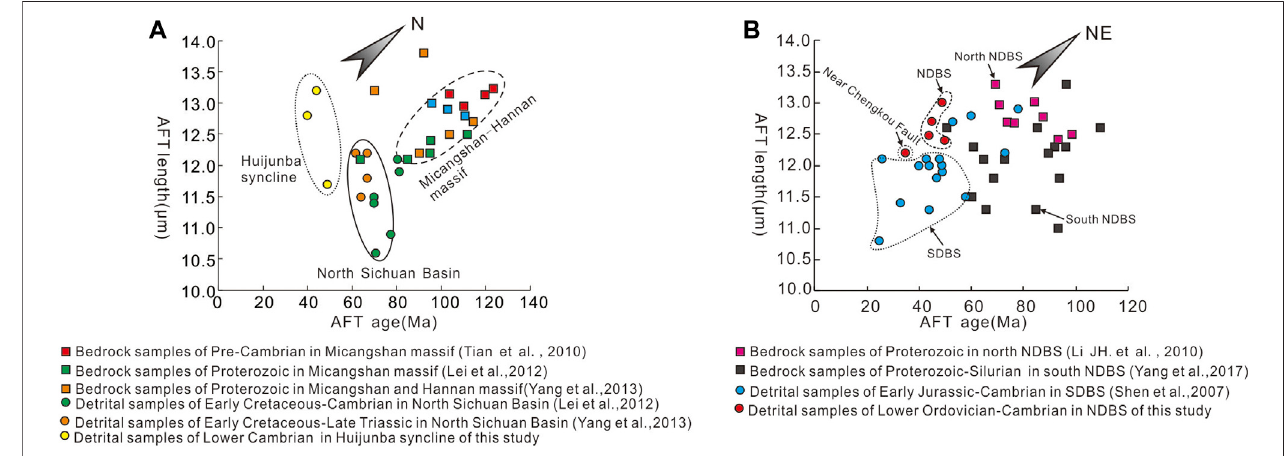
FIGURE 5 | Correlation between AFT ages and lengths of the measured rock samples in the Micangshan area (A) and Dabashan area (B) .